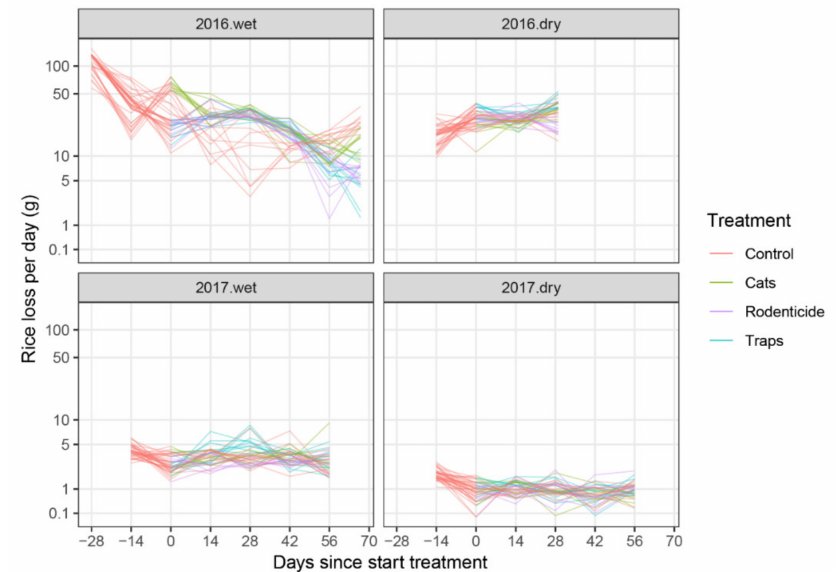
Figure 5. Figure 5. Amount of rice loss per day by rodents taken from baskets placed in farmer stores, split by year and season. Lines connect observations from the same experimental units (baskets) over time (days).